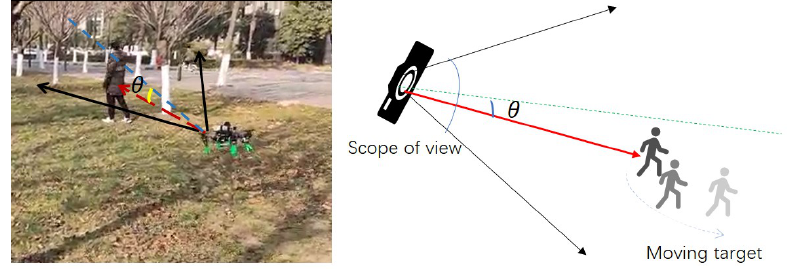
Figure 8. Schematic Diagram of Relative Position of Camera and Tracking Target.